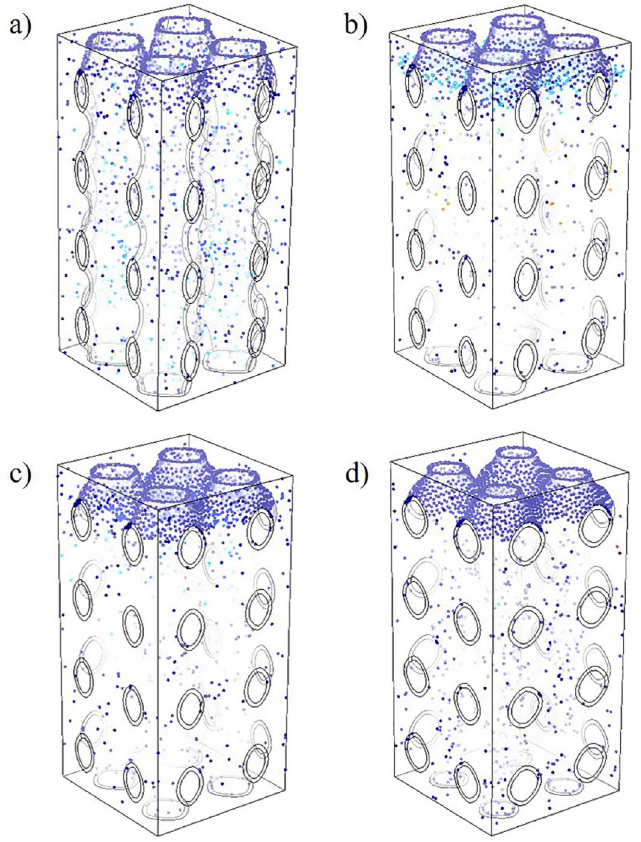
Figure 10. The cell sedimentation and adhesion diagrams: ( a ) cell sedimentation and adhesion maps of P1-3; ( b ) cell sedimentation and adhesion maps of P1-2; ( c ) cell sedimentation and adhesion maps of P2-3; ( d ) cell sedimentation and adhesion maps of P1-1.